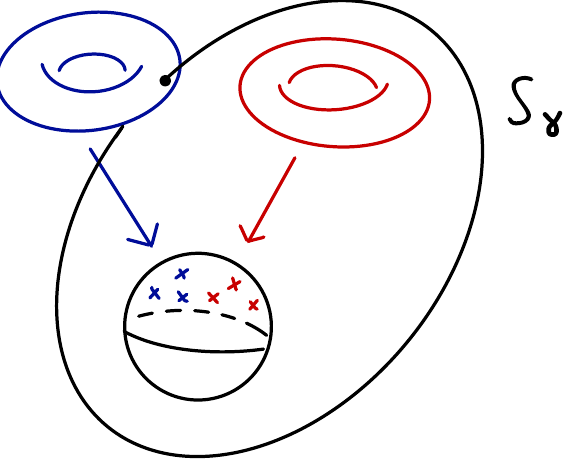
Figure 1 . The Schoen as a double elliptic (cid:12)bration. The blue points on the base represent the degeneration loci of one elliptic (cid:12)bration. The red dots represent the degeneration loci of the other elliptic (cid:12)bration. Picking a section of the blue elliptic (cid:12)bration leaves a divisor S (cid:13)